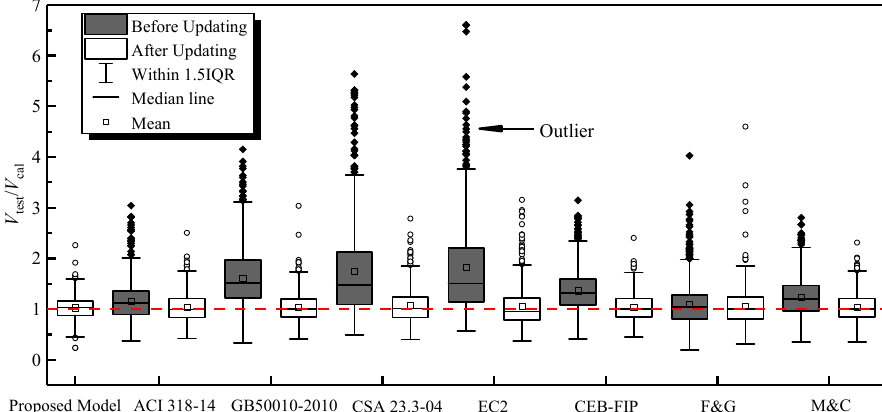
Figure 4. Boxplots of the experiment-prediction ratios.